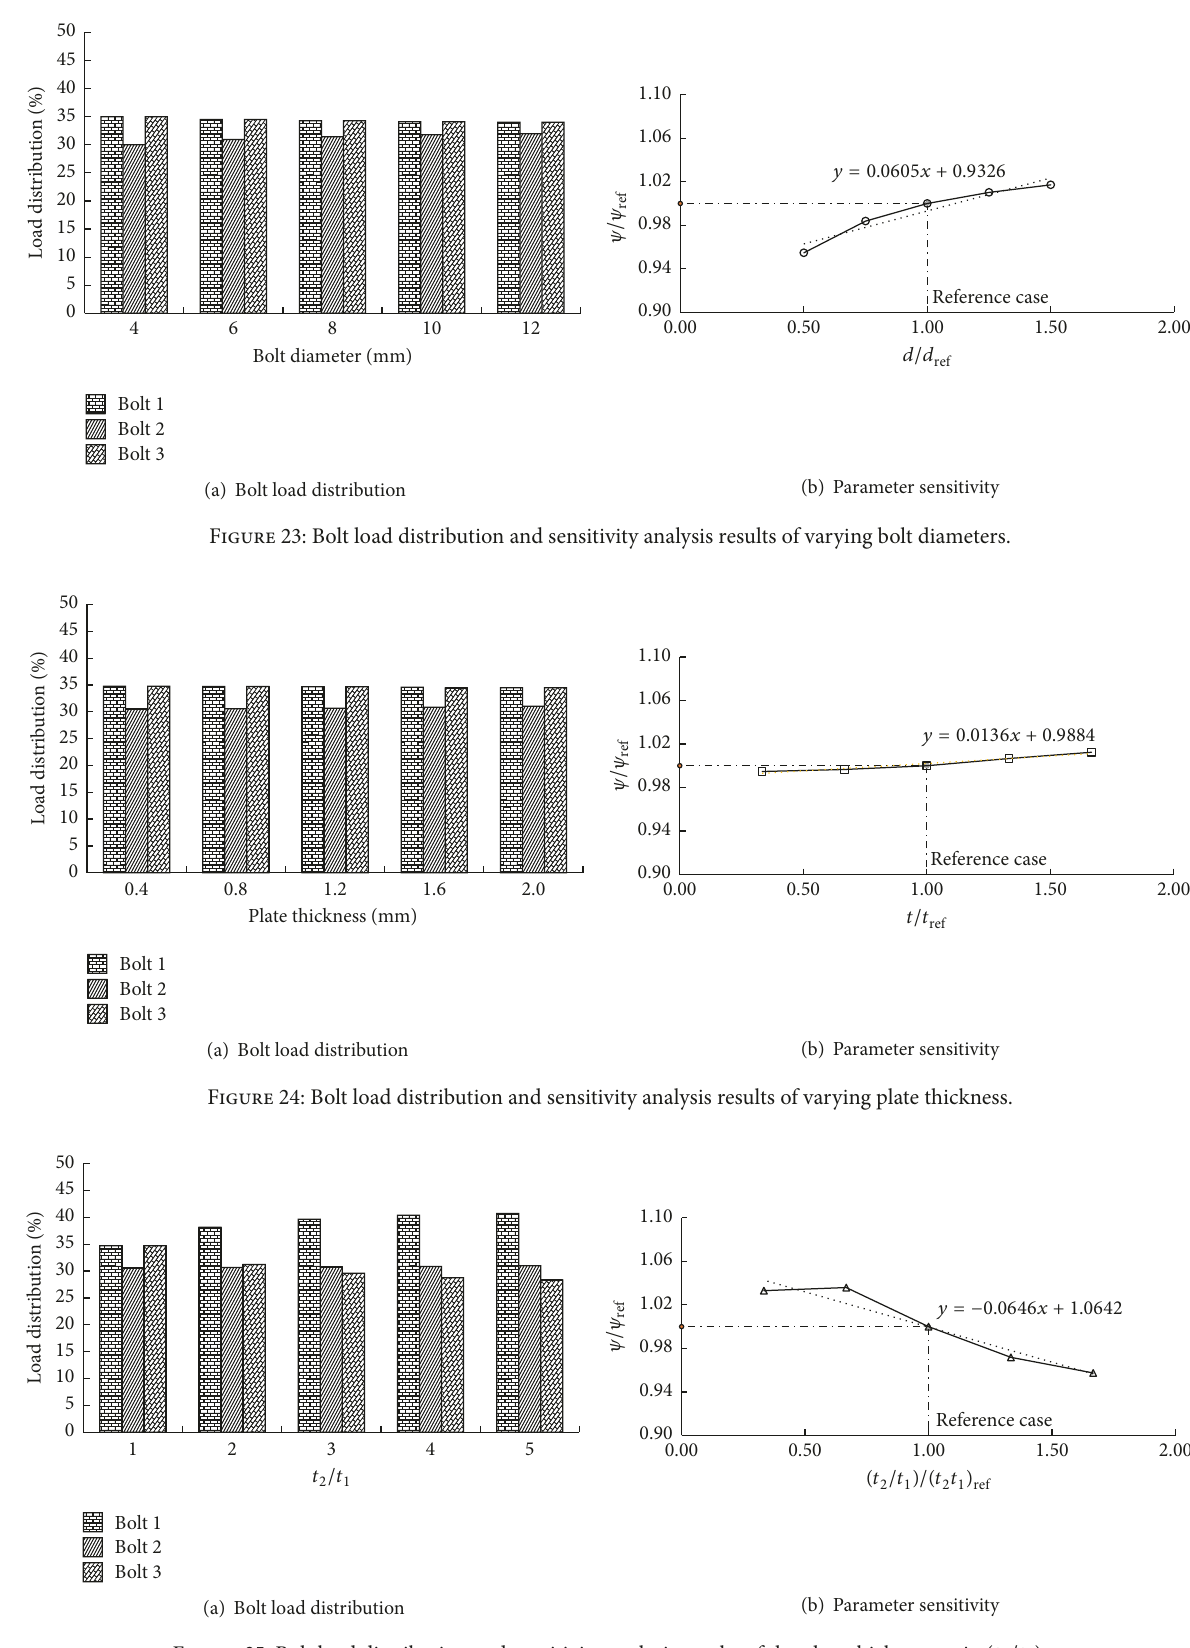
Figure 25: Bolt load distribution and sensitivity analysis results of the plate thickness ratio ( 𝑡 2 /𝑡 1